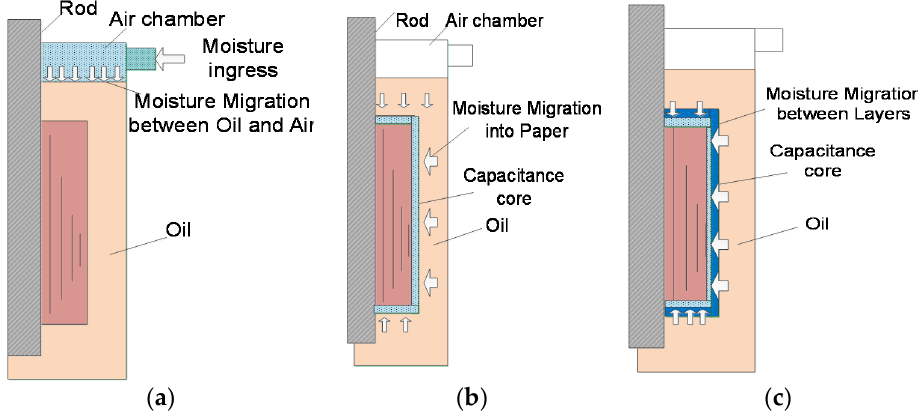
Figure 9. Path of moisture migration in OIP bushing. ( a ) Initial state ( b ) Diffusion state ( c ) Fault state.